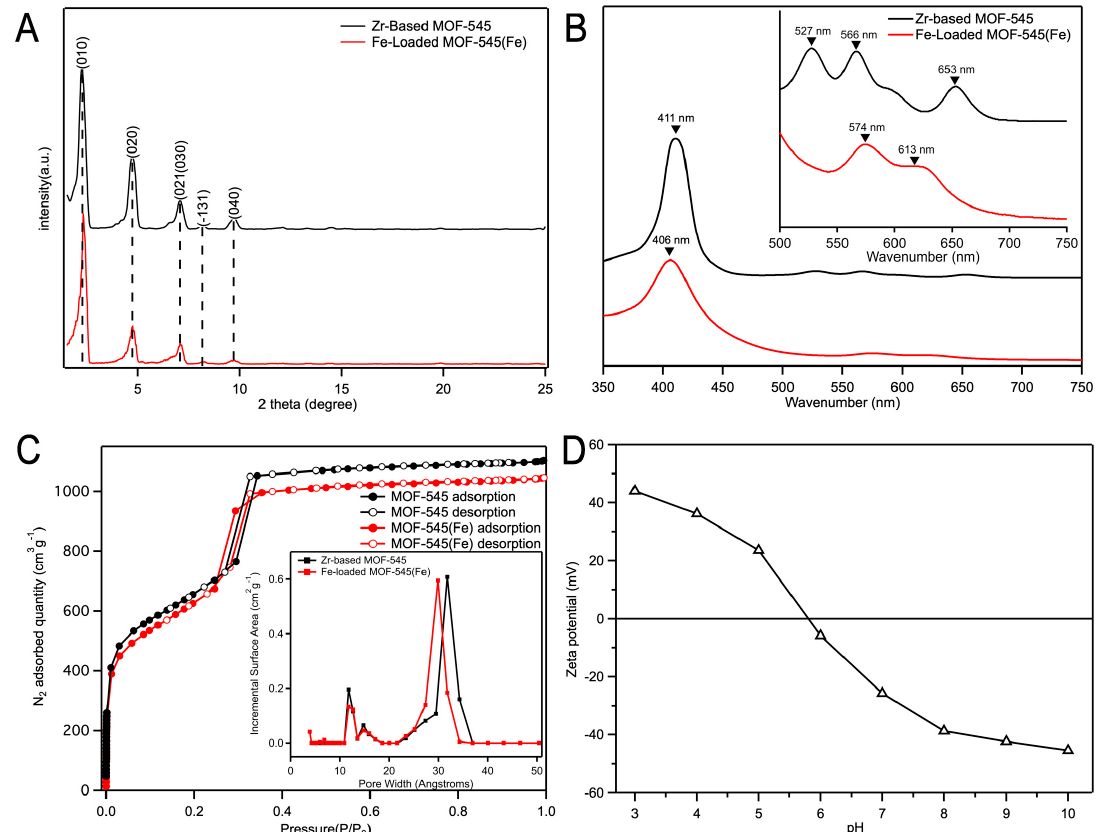
Figure 2. The characterization of Fe-loaded MOF-545(Fe). ( A ) X-ray di ff raction (XRD) patterns of Zr-based MOF-545 (black line) and Fe-loaded MOF-545(Fe) (red line), ( B ) the UV-Vis absorption spectra of Zr-based MOF-545 (black line) and Fe-loaded MOF-545(Fe) (red line), ( C ) N 2 adsorption / desorption isotherms and pore size diameter of the Zr-based MOF-545 and Fe-loaded MOF-545(Fe), ( D ) Zeta potential analysis of Fe-loaded MOF-545(Fe) .